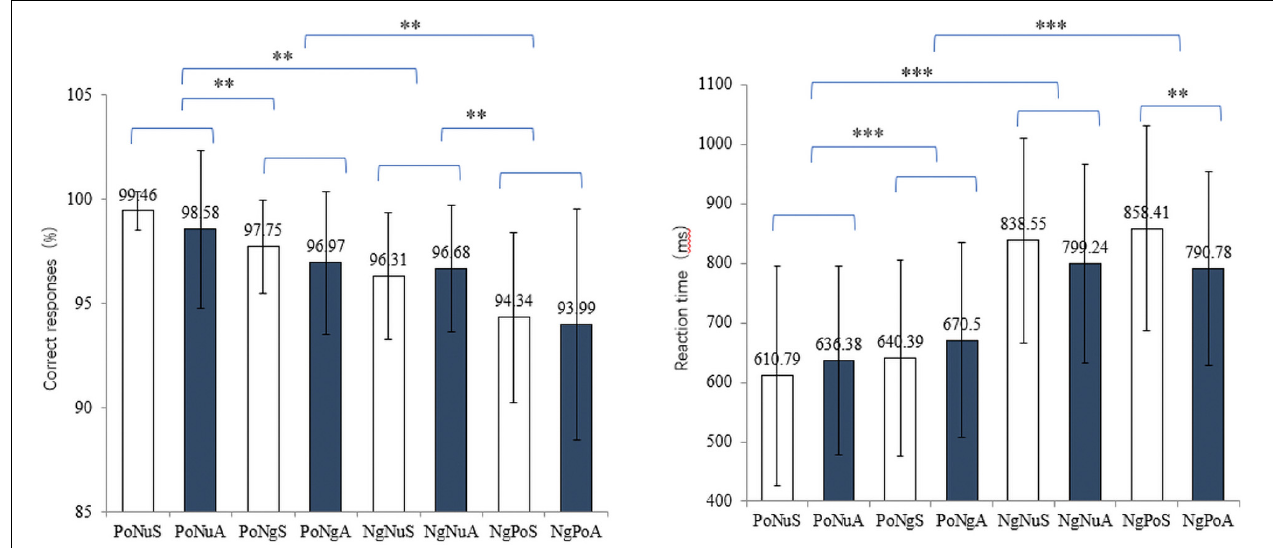
FIGURE 2 | The left and right diagrams demonstrate the correct response ratios and the reaction time of different stimuli conditions. X-axis depicts the eight conditions: PoNuS, PoNuA, PoNgS, PoNgA, NgNuS, NgNuA, NgPoS, and NgPoA. ** and *** represent p < 0.01 and p < 0.001, respectively.